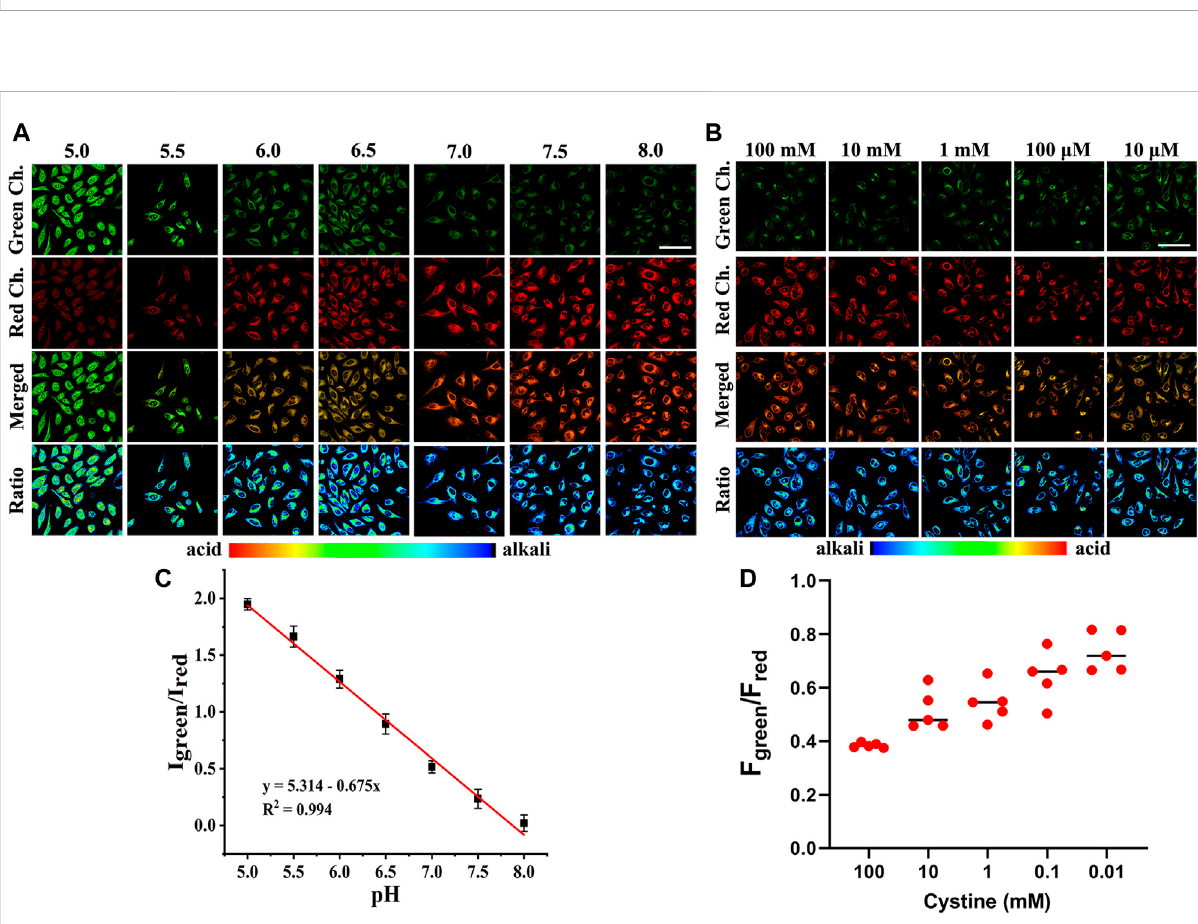
FIGURE 4 (A) CLSM images of Cy-Cys-OH in Panc-1 cells under different pH conditions. (B) CLSM images of Panc-1 cells incubated under different cystine concentrations with 5 μ M Cy-Cys-pH. (C) The linear relationship between the ratio value I green /I red and pH. Error bar: mean ± SD, n = 3. (D) The fl uorescence intensity of green/red ratio to (B) under pretreatment with cystine in different concentration conditions ( n = 5). Green Ch.: λ ex = 552 nm, λ em = 650 – 700 nm, Red Ch.: λ ex = 638 nm, and λ em = 700 – 750 nm. Scale bars: 100 μ